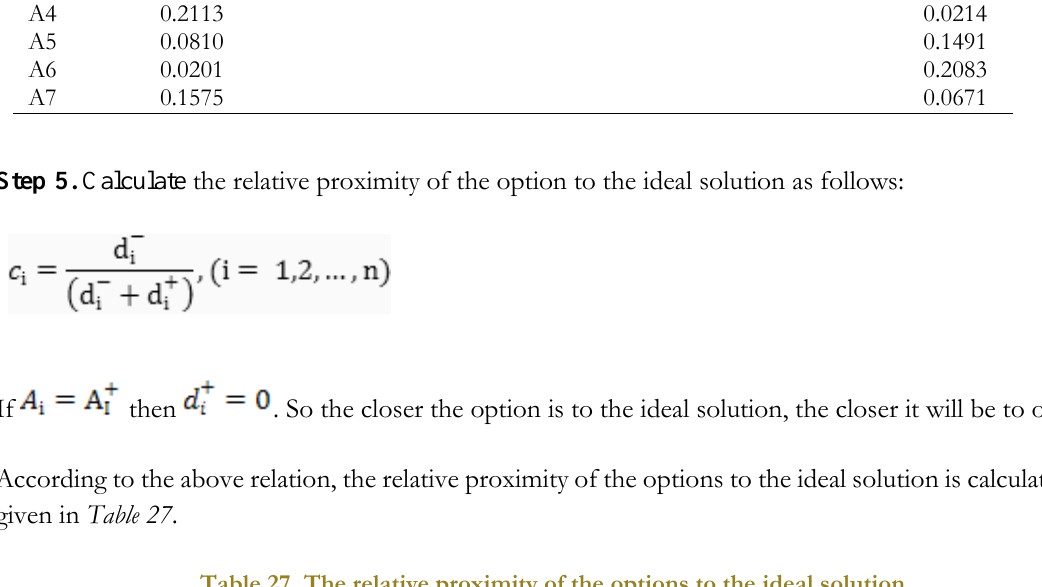
Table 27. The relative proximity of the options to the ideal